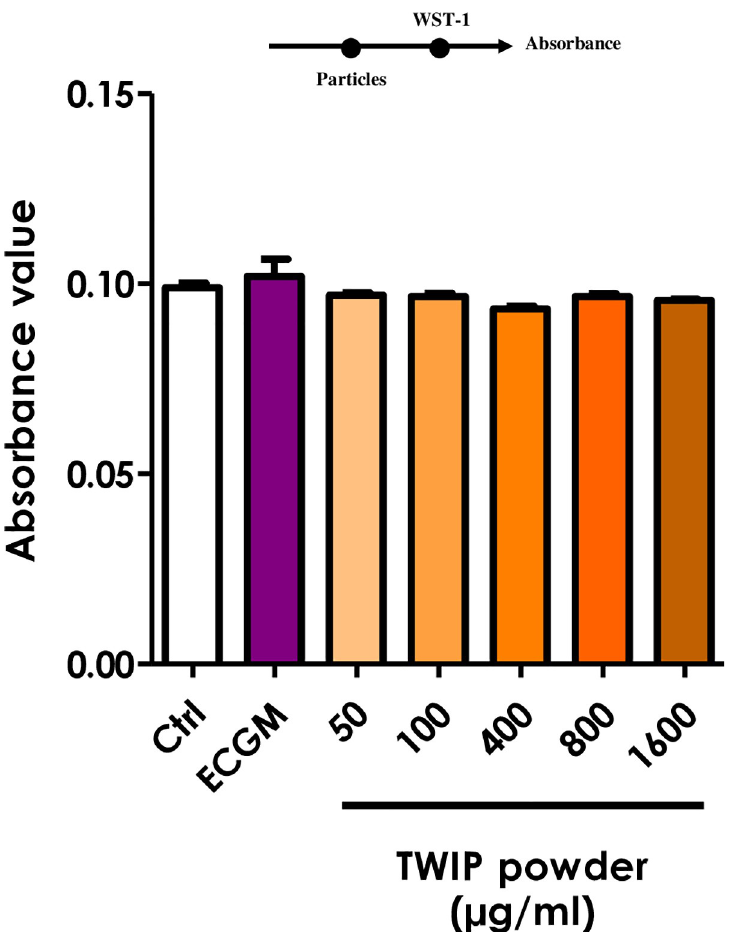
Fig 6. Absorbance is not influenced by TWIP steel particles. Increasing concentrations of TWIP steel powder in ECGM were added into a transparent 96-well plate without cells. Fresh medium with 10% WST-1 reagent was added to the suspensions and the absorbance was read immediately at 450 nm, with 690 nm as reference. Ctrl: cell medium with WST-1 (1:1); ECGM: cell medium without WST-1. Values are means ± SEM (n = 4). On the top: timeline of experiment